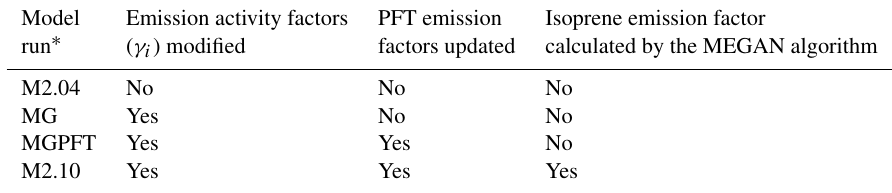
Table 4. Simulations performed in this study.